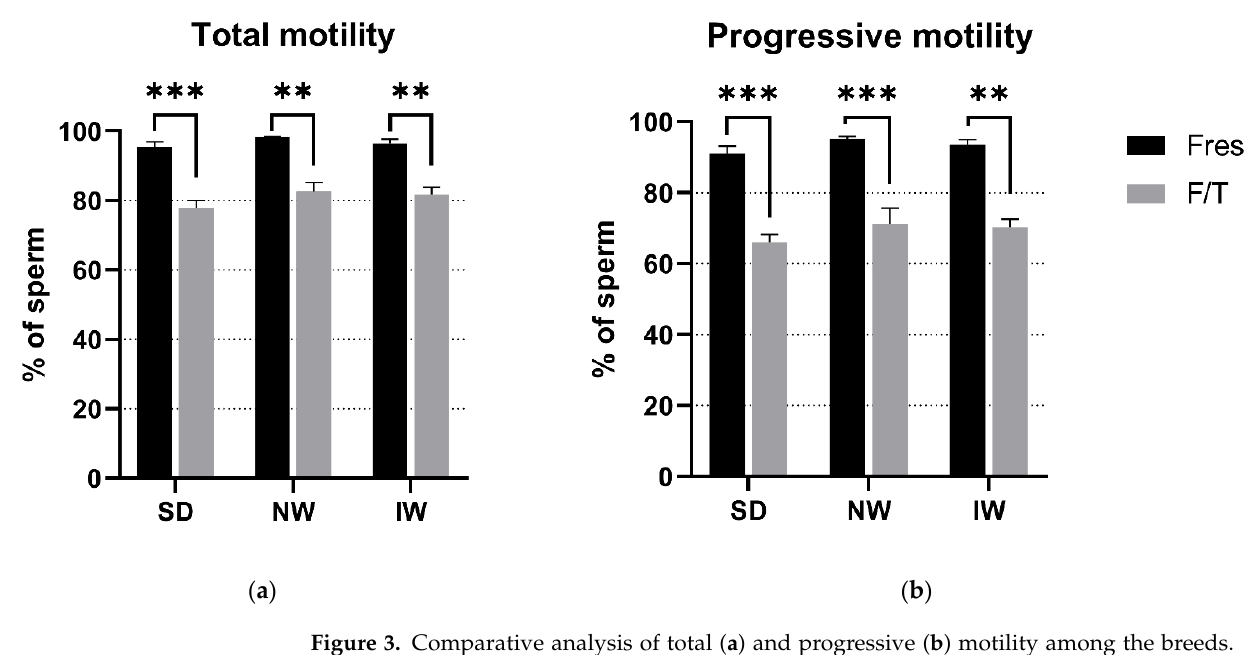
Table 1. Values of total and individual morphological abnormalities in fresh and F/T sperm for each examined breed (%). Abnormality